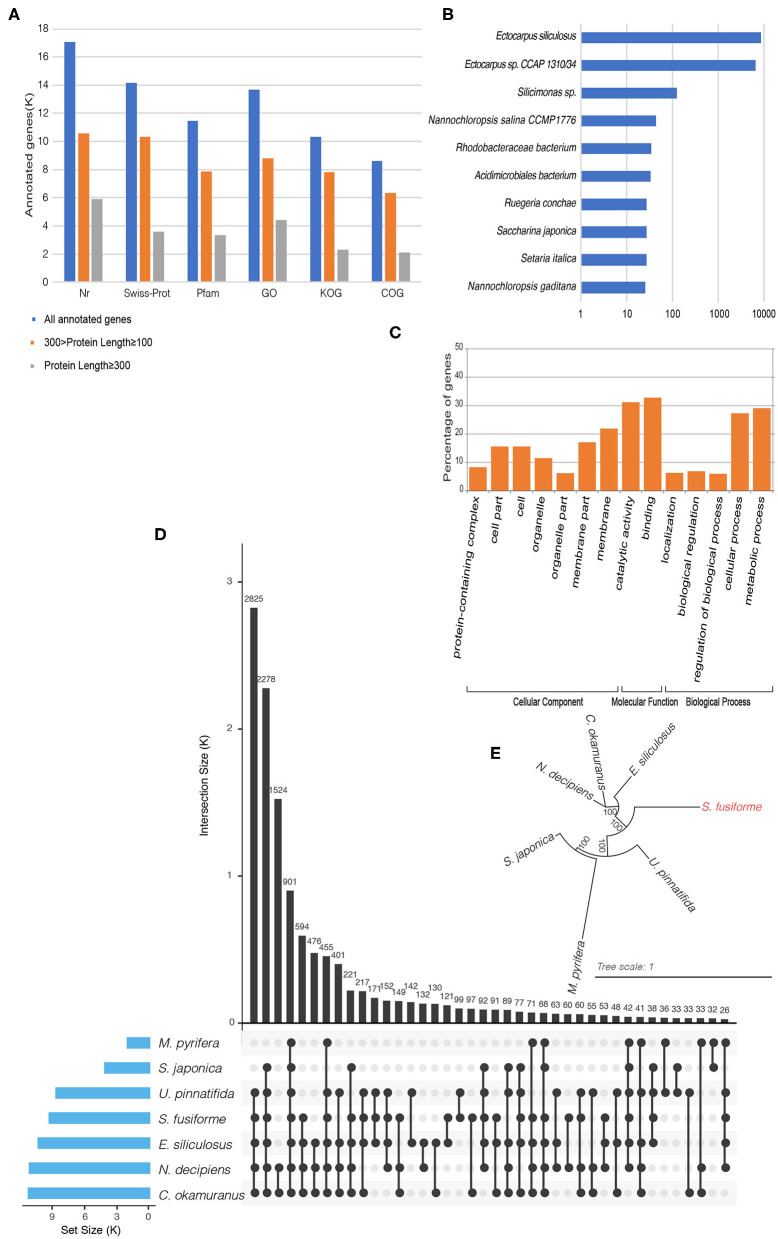
(A) Statistics of gene functional annotations in the S. fusiforme genome. (B) Species distribution in Nr homolog. (C) Gene Ontology classification. Visualization of gene ontology terms (gene number > 1,000) for the putative genes. (D) UpSet plot showing ortholog intersections across the seven brown algae. (E) Phylogenetic tree of seven brown algae using the maximum likelihood method.